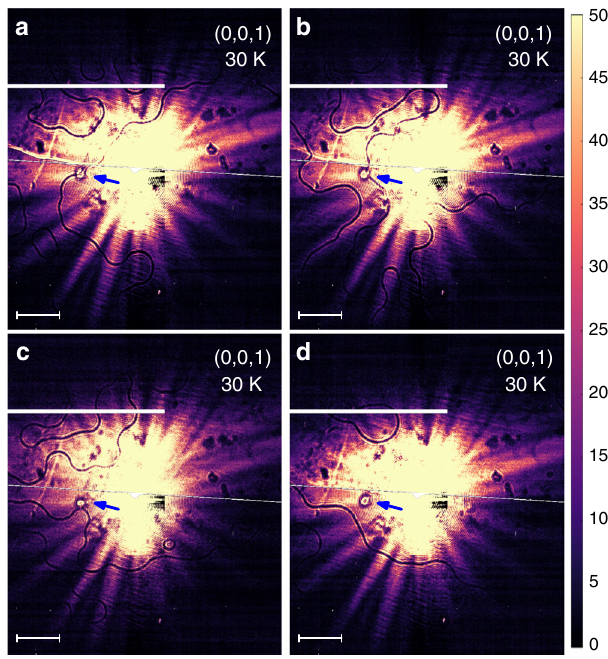
Fig. 5 AFM domain boundaries after several different coolings from above the Néel temperature. The same sample area is shown in panels a – d . Arrows indicate the position of a stationary structural defect, used as a reference. Horizontal scale bars (50 µ m) refer to the distances on the sample surface. Vertical color scale-bar units are